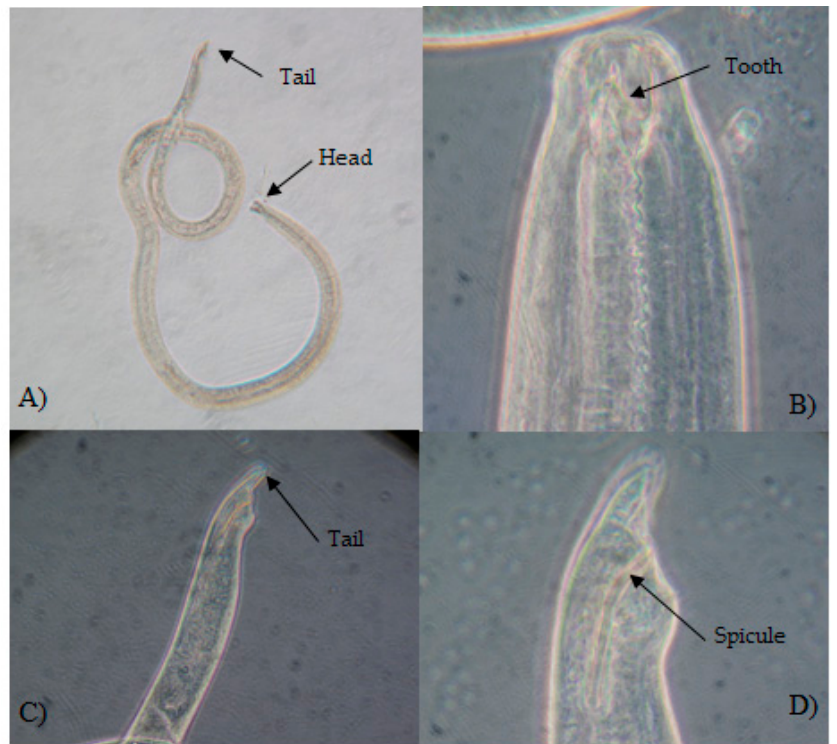
Figure 3. Pontonema cf. simile (Southern, 1914) Filipjev, 1921. Collected in Tulum locality. Adult male. ( A ) Habitus. ( B ) Head showing dorsal tooth. ( C ) Tail short and rounded. ( D ) Posterior part of the body showing spicule and tail.